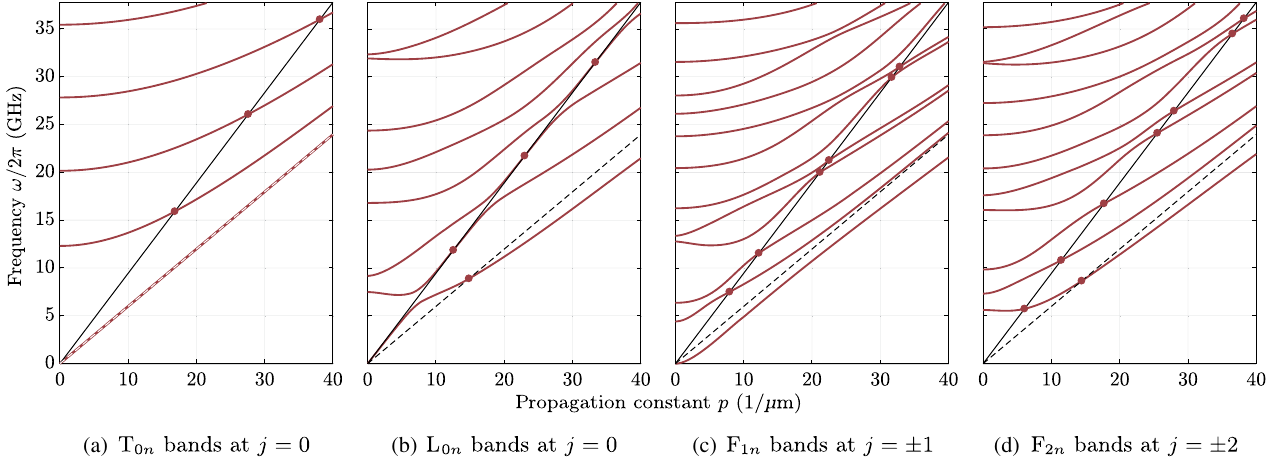
FIG. 5. Band structures of nanofiber phonon modes with different azimuthal order j , for radius R and mechanical properties specified in Appendix E. Panel (a) shows torsional bands, panel (b) longitudinal bands, and panel (c) flexural bands of azimuthal order m ¼ (cid:4) 1 and m ¼ (cid:4) 2 , respectively. The solid black line delineates the longitudinal sound line, the dashed line the transverse sound line [which coincides with the lowest band in Fig. 5(a)]. Solid dots mark intersections of phonon bands with either sound line.